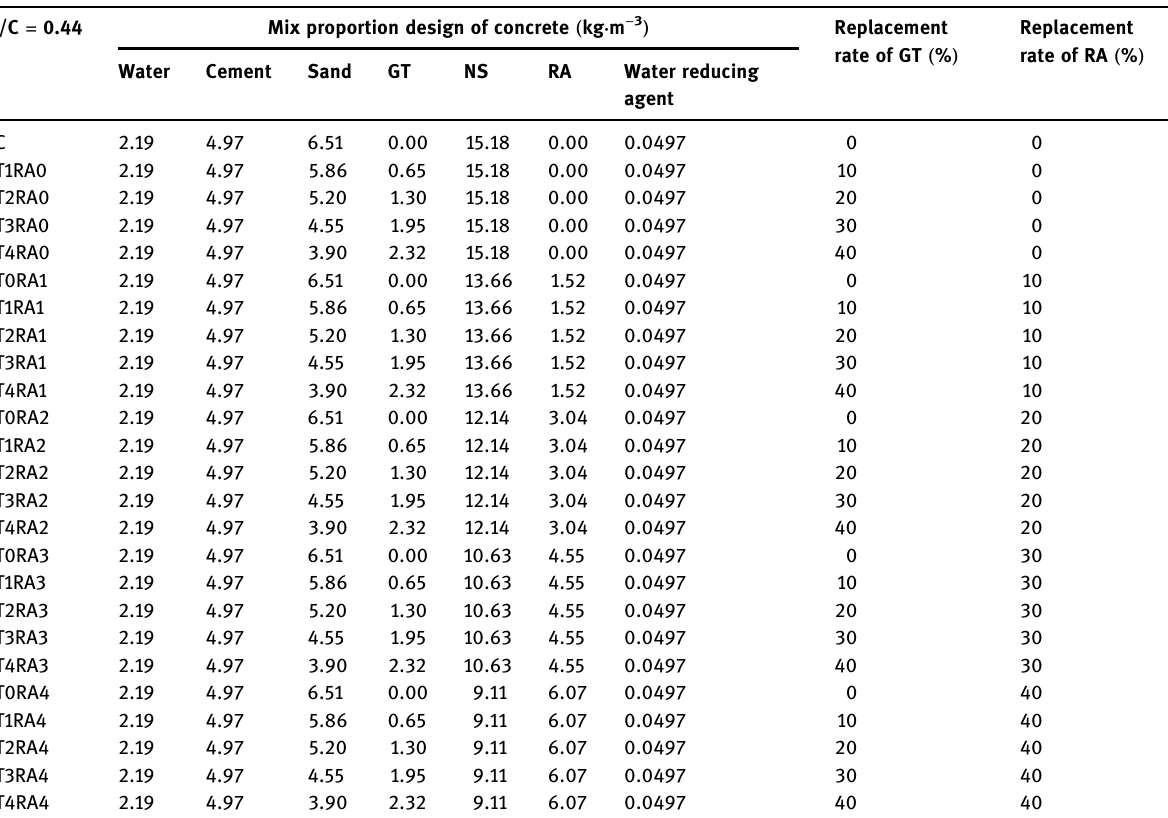
Table 5: Mix proportion design of RA concrete from graphite tailings W/C =